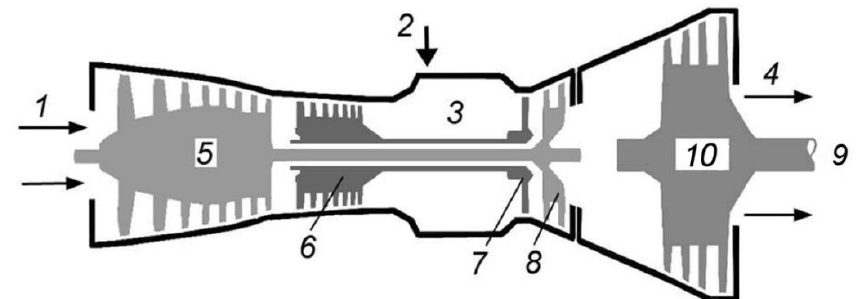
Figure 1. A sketch of a three-shaft GTU: 1—air; 2—fuel; 3—combustion chamber; 4—to the waste heat boiler; 5—low-pressure compressor; 6—high-pressure compressor; 7—high-pressure turbine; 8—low-pressure turbine, 9—synchronous generator, 10—free power turbine (FPT).